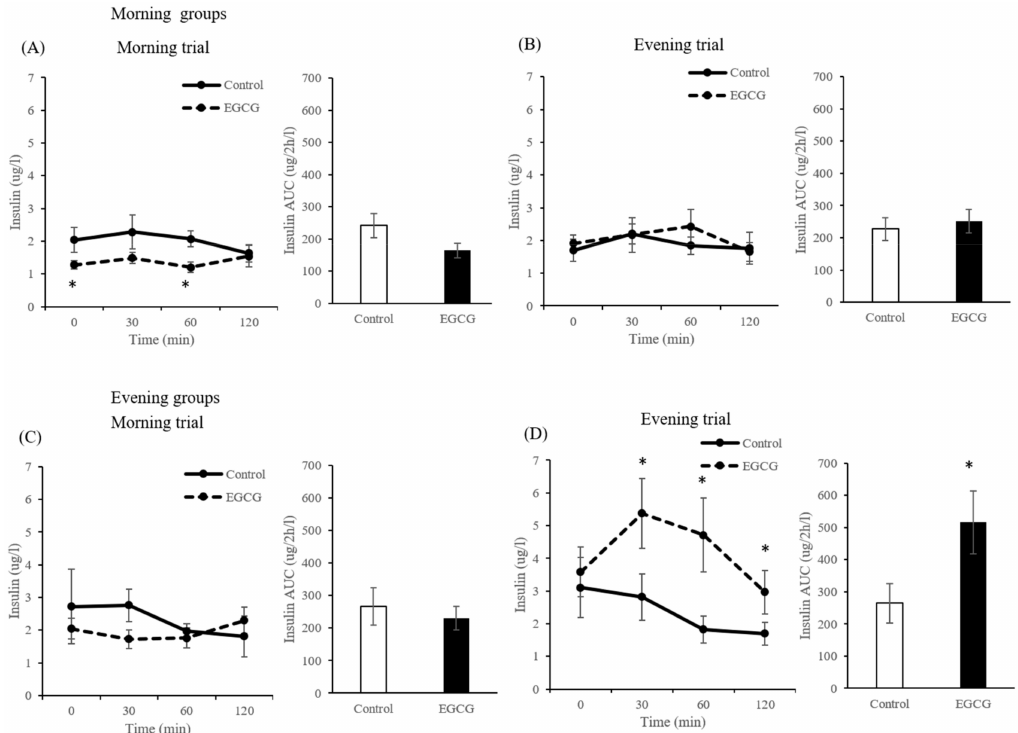
Figure 5. Concentrations and incremental area under the curve (AUC) of plasma insulin in the morning groups (( A ): morning trials, ( B ): evening trials) and evening groups (( C ): morning trials, ( D ): evening trials) in mice. Data are expressed as the mean and SEM, represented by bidirectional bars. * Mean values were significantly di ff erent from that of control group at same